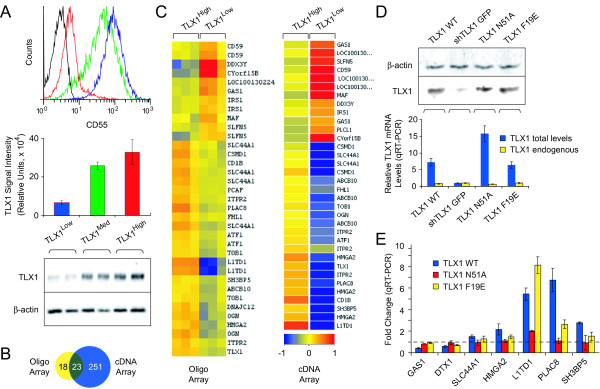
Structure-function analysis of TLX1-mediated transcriptional regulation in ALL-SIL T-ALL cells. (A) TLX1 protein levels inversely correlate with CD55 surface levels. Top, CD55 FACS analysis. Histogram colors indicate: blue, TLX1Low; green, TLX1Med; and red, TLX1High. Bottom, TLX1 Western blot. TLX1High levels were 6.5× higher and TLX1Med levels were 4.9× higher than TLX1Low levels (P < 0.0001). The difference between the TLX1High and TLX1Med levels was statistically significant (P < 0.05). (B) Venn diagram comparing candidate TLX1 target genes derived from two different microarray technologies: Affymetrix data have been described [50]; cDNA array targets were selected based on correlation of expression levels with TLX1 protein levels (r > 0.9 or < -0.9; 1% FDR; n = 3-4). (C) Hierarchical clustering of genes identified in both profiling experiments. (D) TLX1 levels in knockdown and "rescued" ALL-SIL populations: top, Western blot; bottom qRT-PCR. The TLX1 knockdown populations expressing coding regions of wild-type or mutant forms of TLX1 are: TLX1 WT, wild-type; TLX1 N51A, DNA binding-deficient mutant; TLX1 F19E, TLE binding-deficient mutant; shTLX1 GFP, TLX1 knockdown plus GFP reporter. Total or endogenous TLX1 mRNA levels were determined using primers targeting coding or 3' noncoding regions of TLX1, respectively. The data is normalized to TLX1 knockdown expressing GFP alone (shTLX1 GFP). (E) TLX1 signature gene expression in the populations described in D. The data is normalized to TLX1 knockdown expressing GFP alone (P values are indicated in the text and Additional file 4; n = 2-3 biological replicates, each comprising 3 technical replicates).